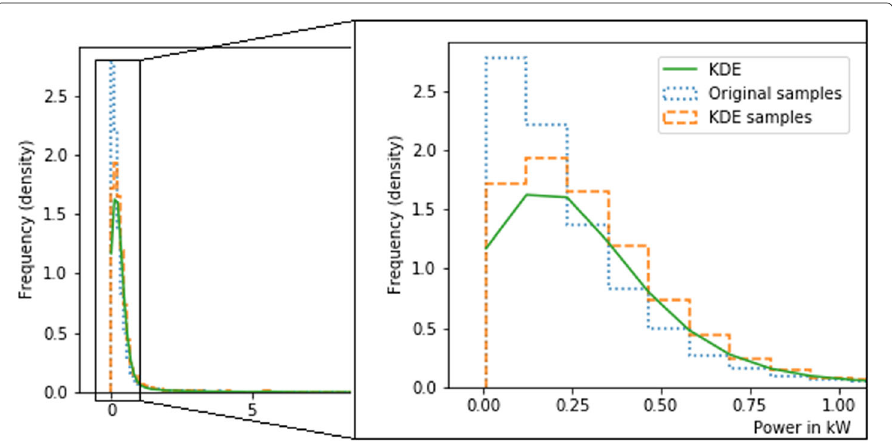
Fig. 10 Gaussian KDE (green line) applied to household data (blue dotted line). Samples for one year drawn from the KDE function (orange dashed line). The area between 0.0 and 0.75 kW is smoothed a bit too